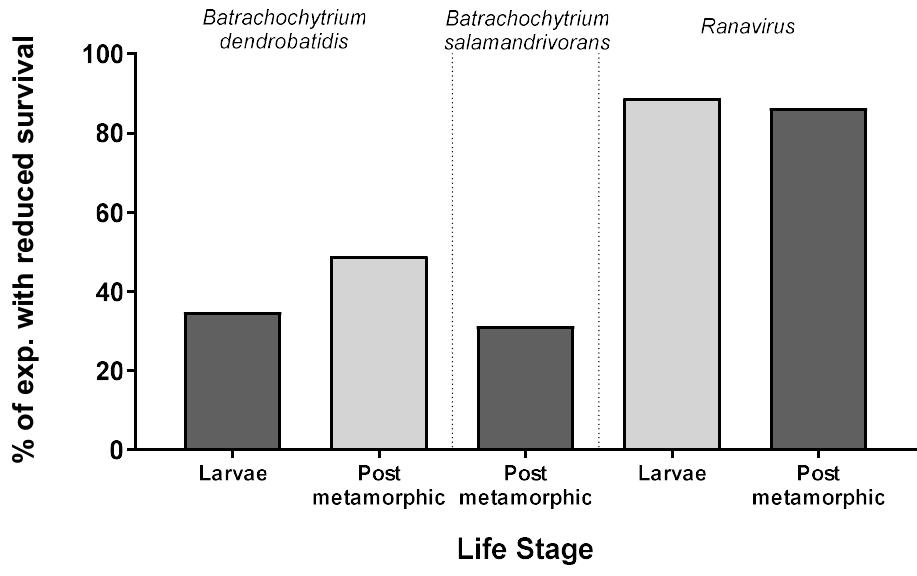
Figure 6. Percentages of experiments showing reduced survival at a single life stage. These data are percentages from Table 1 (Experiments showing reduced survival/total # of experiments with survival as an endpoint).